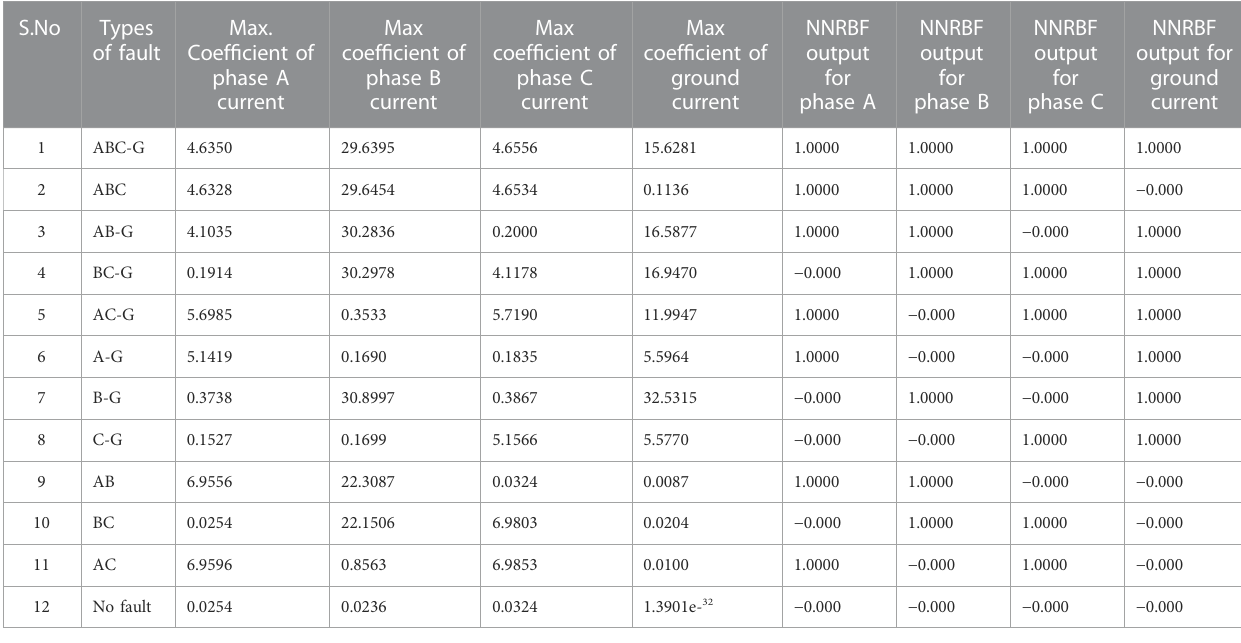
TABLE 1 Ground resistance 20 Ω detection at 5th